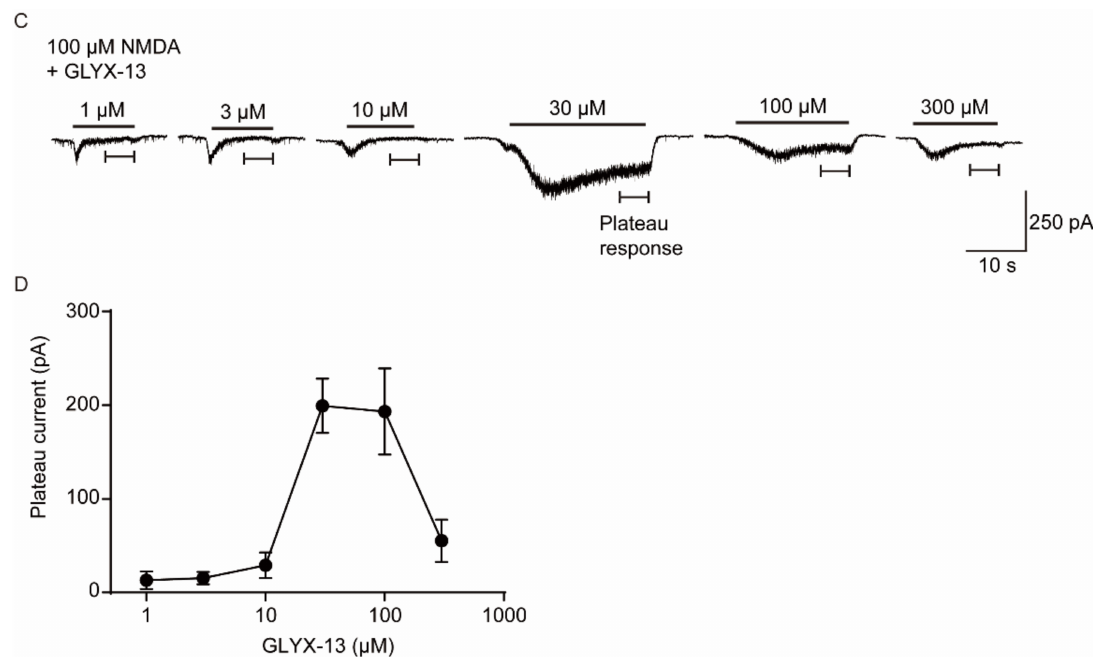
Figure 5. GLYX-13 potentiated responses of NMDA receptors in mice primary cortical neurons. ( A ) Inward I NMDA were activated by application of 100 µ M NMDA and co-application of 100 µ M NMDA and 30 µ M GLYX-13; ( B ) Mean and standard error (shown in red) of whole cell I NMDA in the presence of 100 µ M NMDA and 100 µ M NMDA together with 30 µ M GLYX-13. Black circles illustrated I NMDA from individual experiments. *** p < 0.001, paired two-tailed Student’s t -test; ( C ) Inward NMDAR-mediated currents were activated by application of 100 µ M NMDA with six different concentrations of GLYX-13; ( D ) Concentration-response curve for the effect of GLYX-13 on NMDA receptors. Data were represented as mean ±